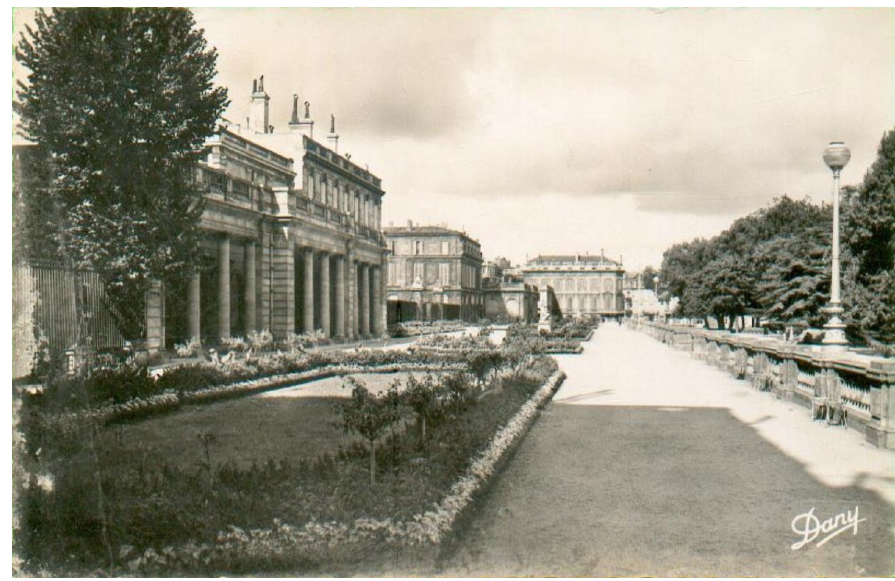
Figure 1. Postcard of the “Terrasse du Jardin Public” in Bordeaux, during the 1940s. Coll: L.